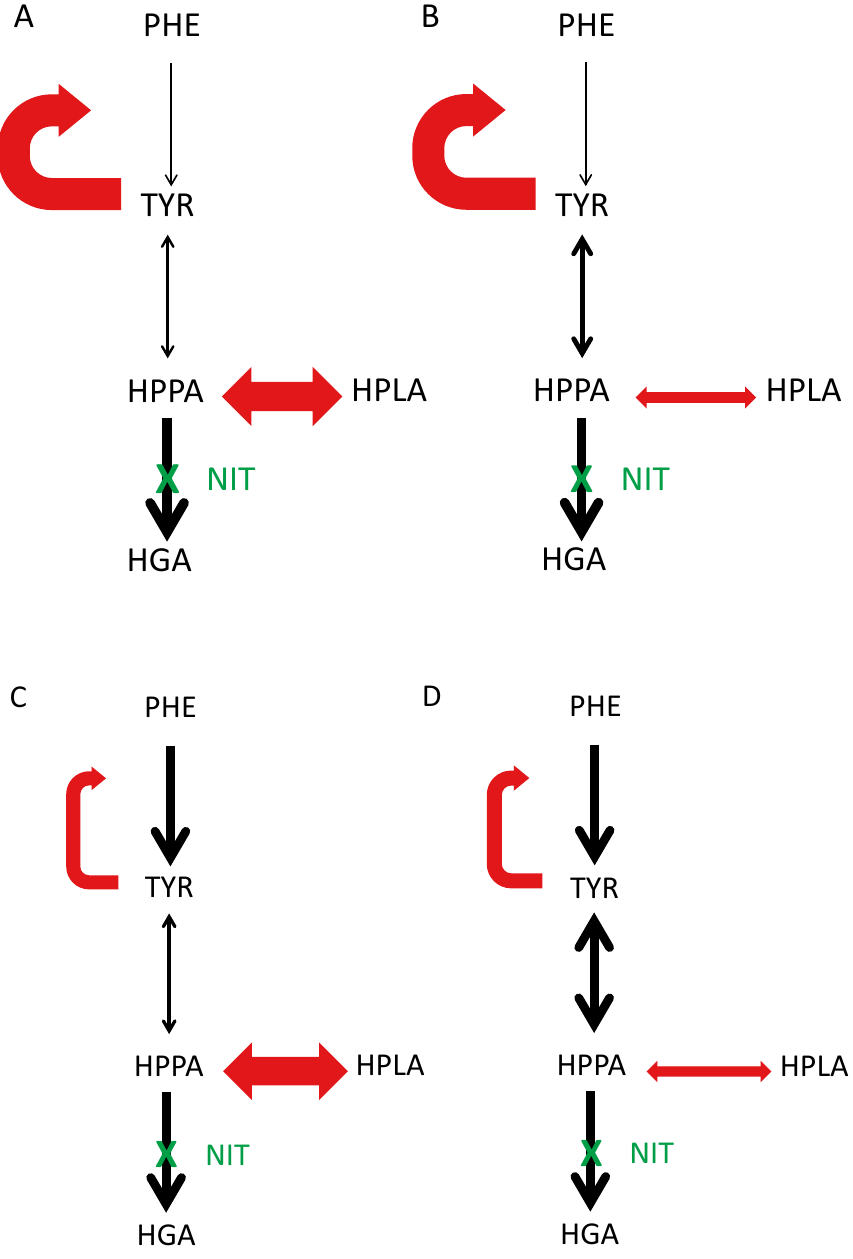
Figure 6. ( A , B ) A cartoon representation of changing relationships between PHE, TYR, HPPA and HPLA during nitisinone therapy. ( A ) Highlights the most adapted state showing lesser conversion of PHE to TYR (solid curved red arrow), and similarly higher conversion of HPPA to HPLA (a straight solid red arrow) as well as lower conversion between HPPA and TYR (a faintest straight black arrow). ( B ) Highlights an intermediate adapted state showing lesser conversion of PHE to TYR (solid curved red arrow), and lower conversion of HPPA to HPLA (a straight fainter red arrow) as well as an intermediate conversion between HPPA and TYR (the fainter straight black arrow). ( C ) Highlights an intermediate adapted state showing greater conversion of PHE to TYR (fainter curved red arrow), a higher conversion of HPPA to HPLA (a straight solid red arrow) as well as an intermediate conversion between HPPA and TYR (the fainter straight black arrow). ( D ) Highlights the least adapted state showing high conversion of PHE to TYR (fainter curved red arrow), a low conversion of HPPA to HPLA (a straight fainter red arrow) as well as lower conversion between HPPA and TYR (a solid straight black